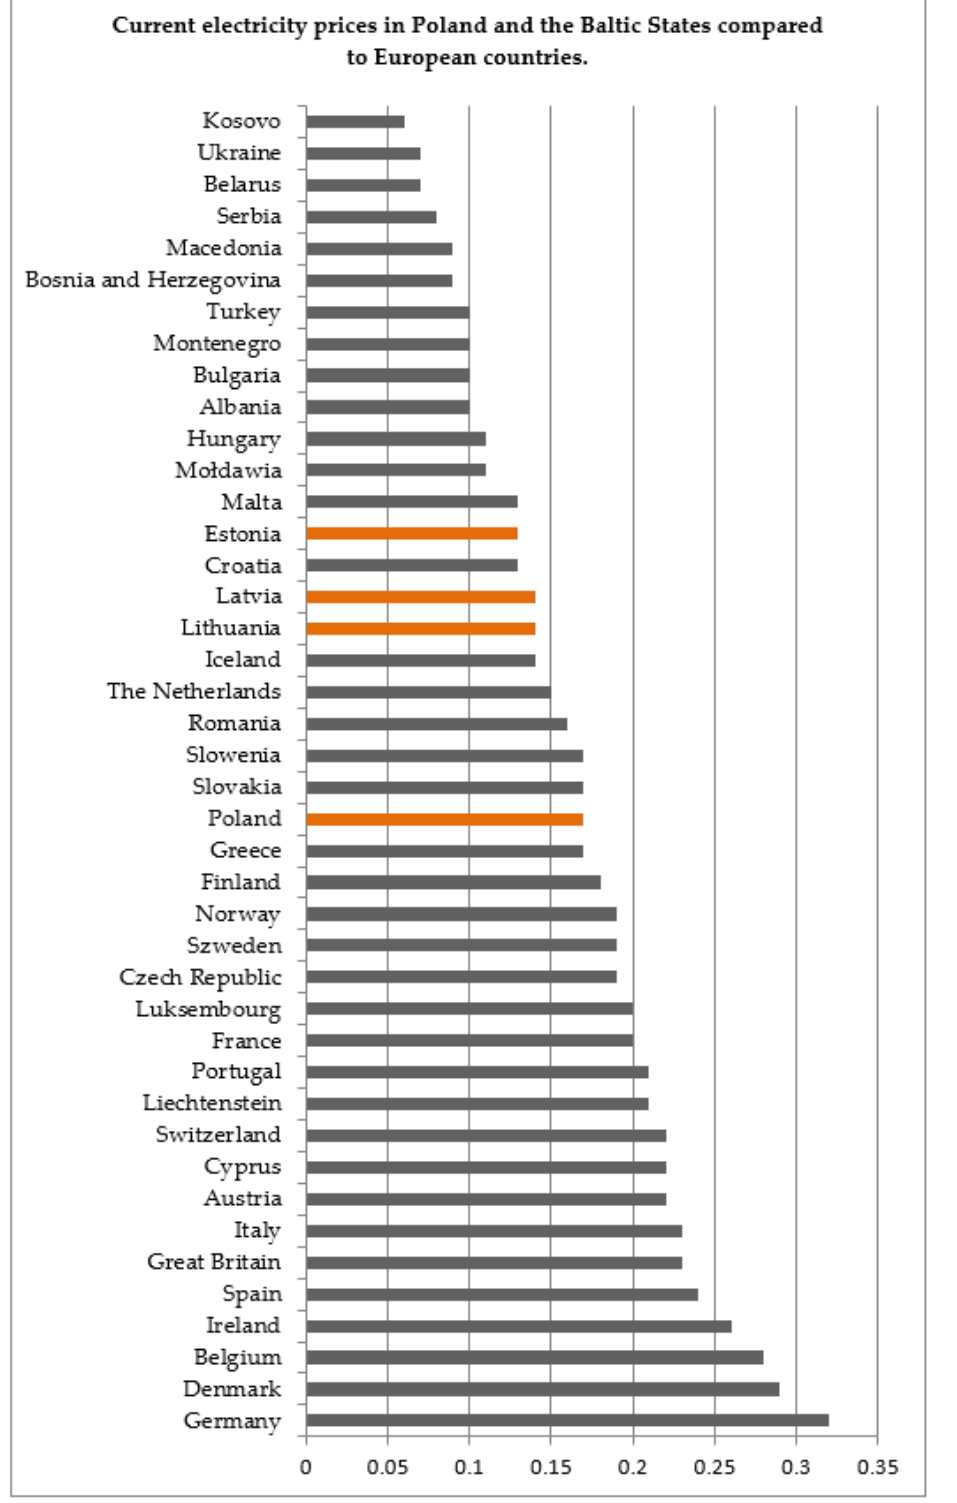
Figure 3. Current electricity prices in Poland and the Baltic States compared to European countries [51].